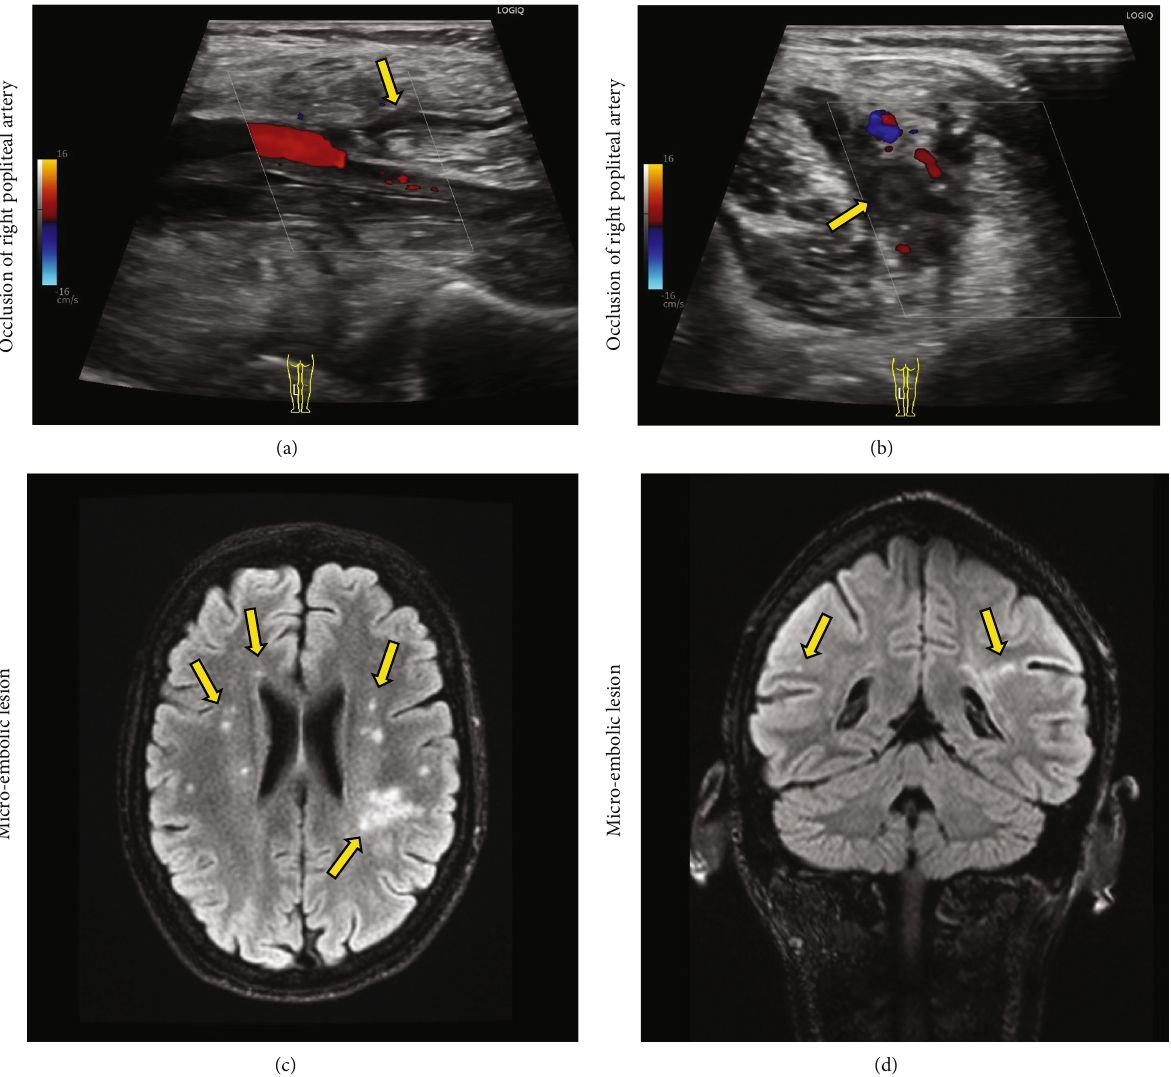
Figure 2: Ultrasound images of the right popliteal artery in the long and short axis (a and b, respectively) show partial obstruction of fl ow as evident on color doppler imaging (yellow arrows). Magnetic resonance imaging in the horizontal and coronal planes (c and d, respectively) shows multiple micro-embolic lesions scattered across both hemispheres of the brain (yellow